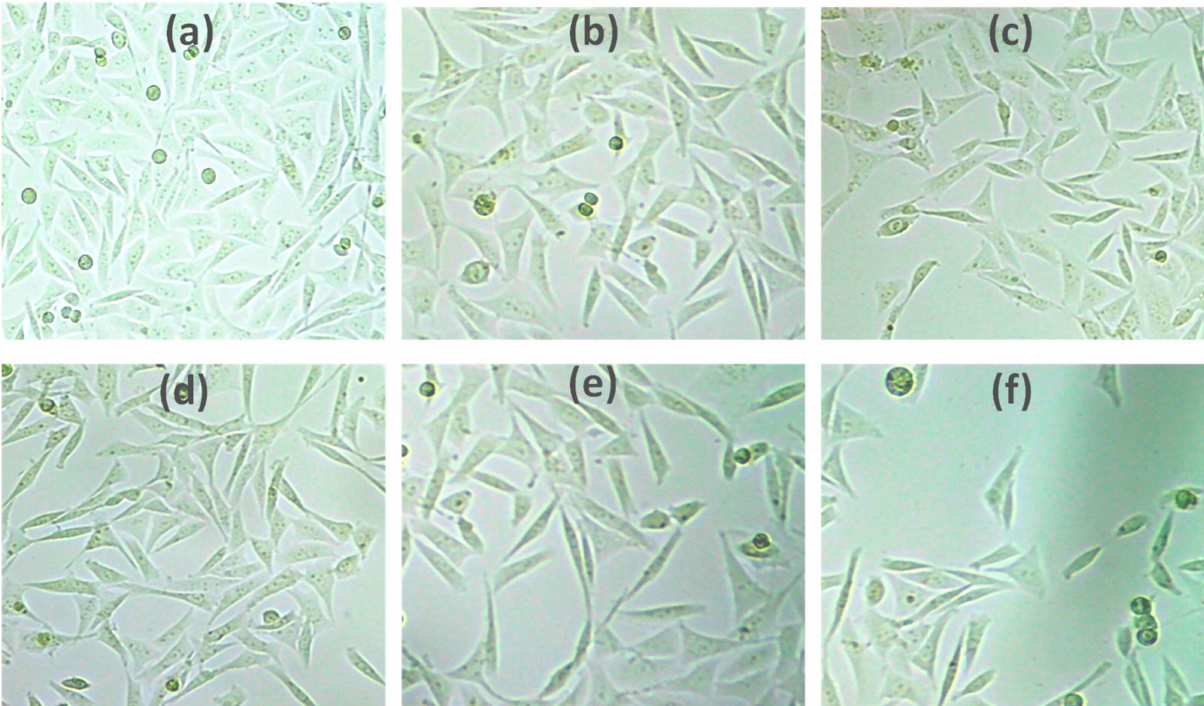
Figure 5. Morphological changes of the human breast cancer cell line MCF-7 after given treatment; ( a ) control; ( b ) 1 µ g; ( c ) 5 µ g; ( d ) 10 µ g; ( e ) 15 µ g; ( f ) 20 µ g.